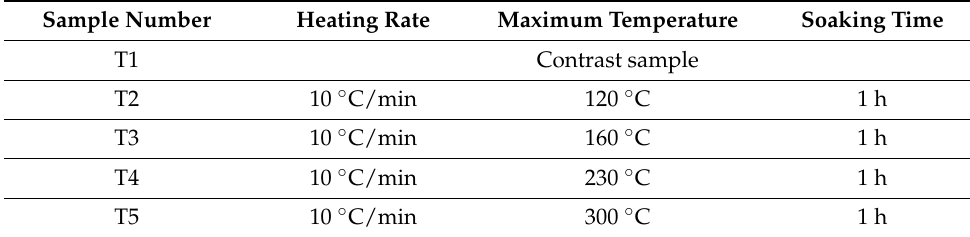
Table 2. Thermal load treatment